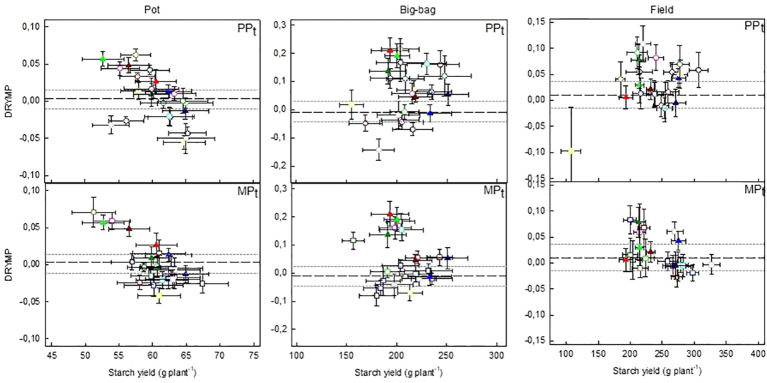
Relationship between drought tolerance (DRYMp) and starch yield under optimal water supply in lines selected for superior drought tolerance. Mean and standard error (SE) of DRYMp depicted against mean and SE of tuber starch yield of the lines in PPt and MPt in pot, big-bag and field trials. Tuber starch yield was normalized to account for the spatial effects in the experiments. The reference lines indicate the mean (dashed line) and 95% confidence interval (dotted line) of DRYMp in the respective test system. Lines common in PPt and MPt are represented by closed triangles, including three lines with superior performance: AR185 (light green triangle), AR196 (dark green triangle), and AR121 (light red triangle). The outlier in PPt, field is line AR21. Number of pot trials 3, big-bag trials 3, field trials 7. Data for the lines of MPs are shown in
Data Sheet 1
,
Figure S4
.